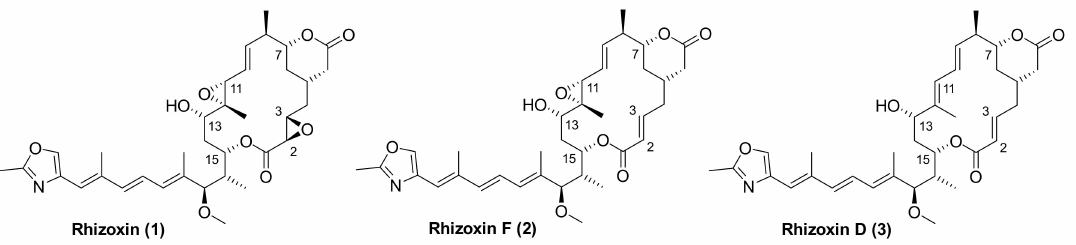
Figure 1. Molecular structures of rhizoxin ( 1 ), rhizoxin F ( 2 ), and rhizoxin D ( 3